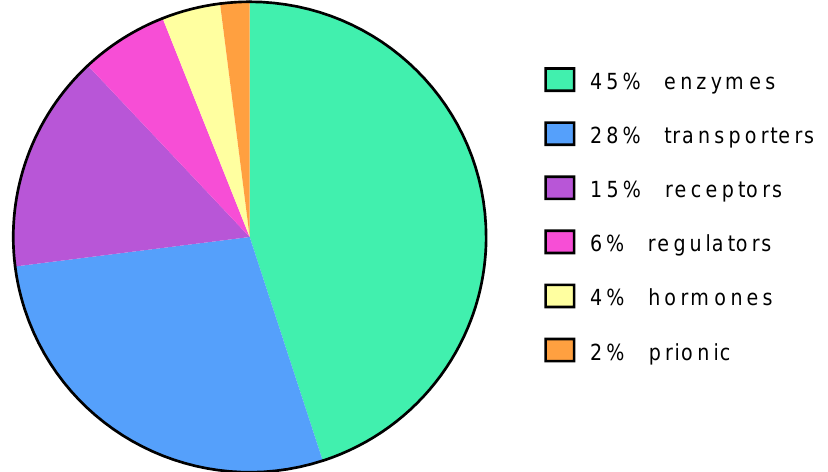
Figure 3. Protein targets of pharmacological chaperones based on their function.